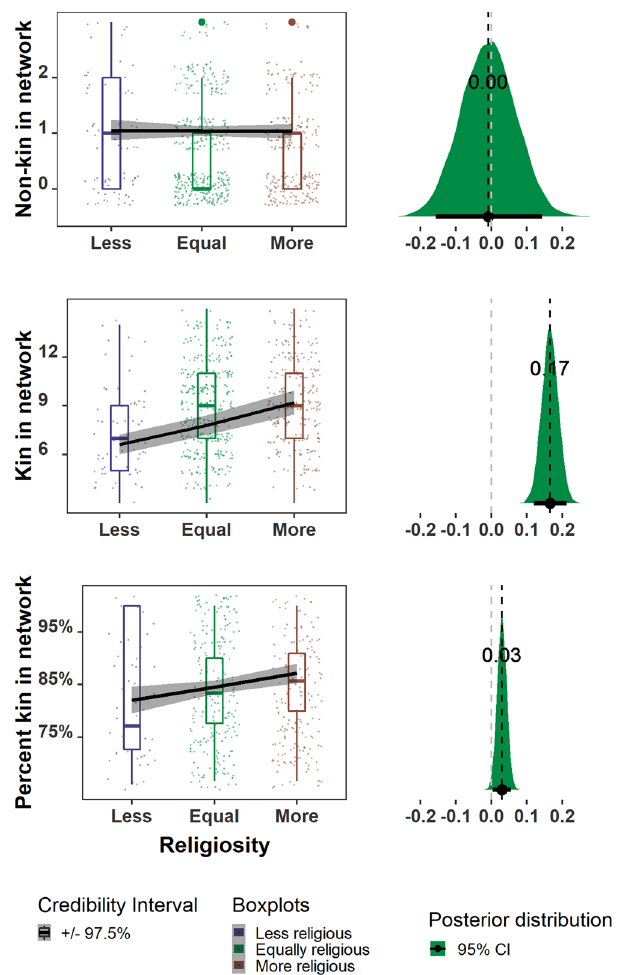
row), more family members in their networks (3rd row), and a higher percentage of family members in their networks (bottom row). Raw data points and error bars represent 97.5 percent credibility intervals for